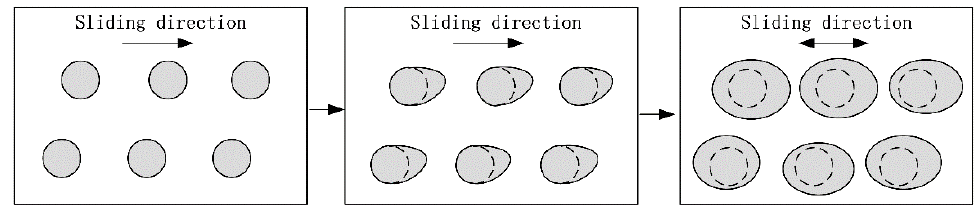
Figure 7. The transfer mechanism of the WS 2 in the dimples.